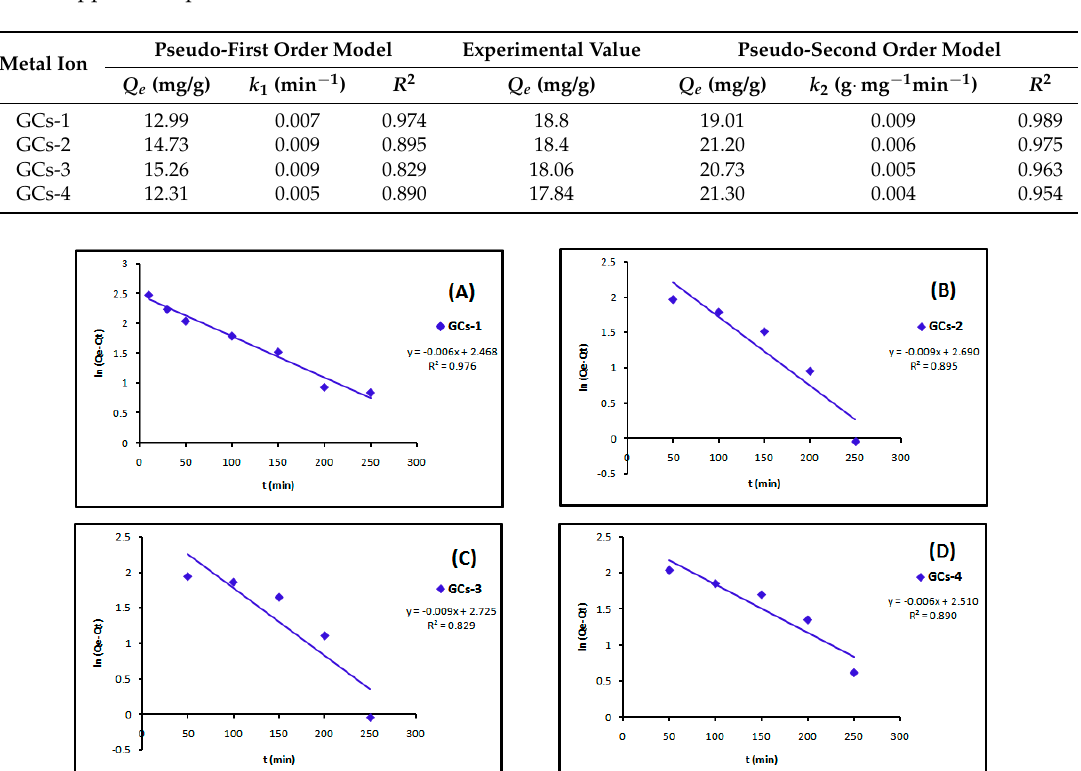
Table 3. Constants and correlation coefficient of pseudo-first order and pseudo-second order kinetics of nickel adsorption.